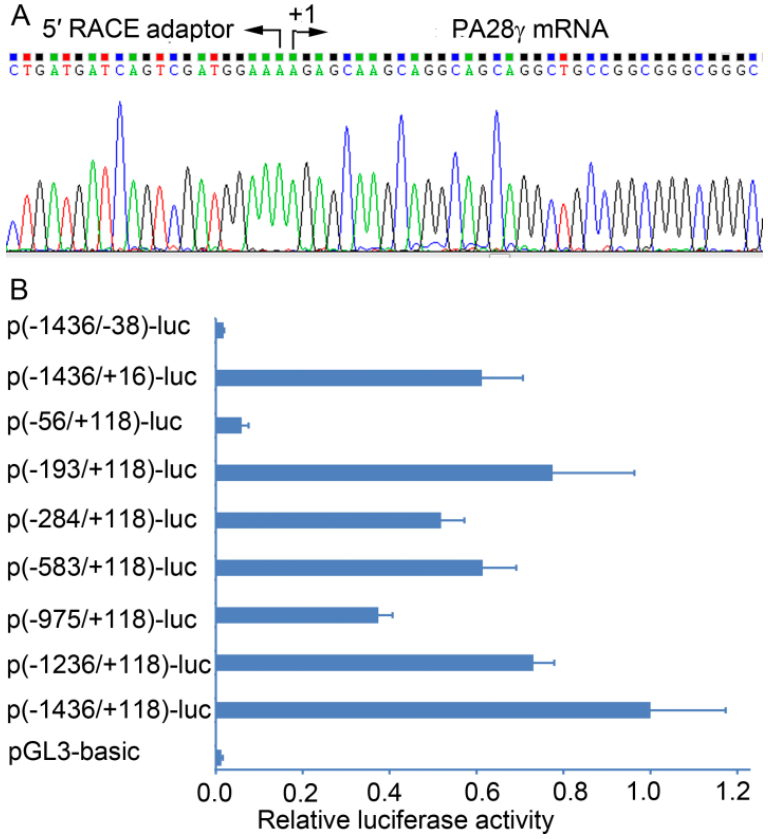
Figure 1. Identification of the transcription start site (TSS) and basal promoter of the human PA28 γ gene. ( A ) Partial sequencing chromatogram of the 5' RACE products. Total RNA from HEK293 cells was treated sequentially with calf intestine alkaline phosphatase and tobacco acid pyrophosphatase, and then ligated to the 5' RACE adaptor. The ligated RNA was reverse transcribed into cDNA and amplified. The final PCR products were cloned into the pMD18-T vector and sequenced; ( B ) Plasmids containing sequentially deleted fragments of the putative PA28 γ promoter ( − 1436 to +118) were transfected into HEK293 cells. Luciferase activity was measured at 36 h post-transfection. The data (means ± S.D.) are represented as the percentage activity relative to that observed in p( − 1436/+118)-luc. RACE: rapid amplification of cDNA